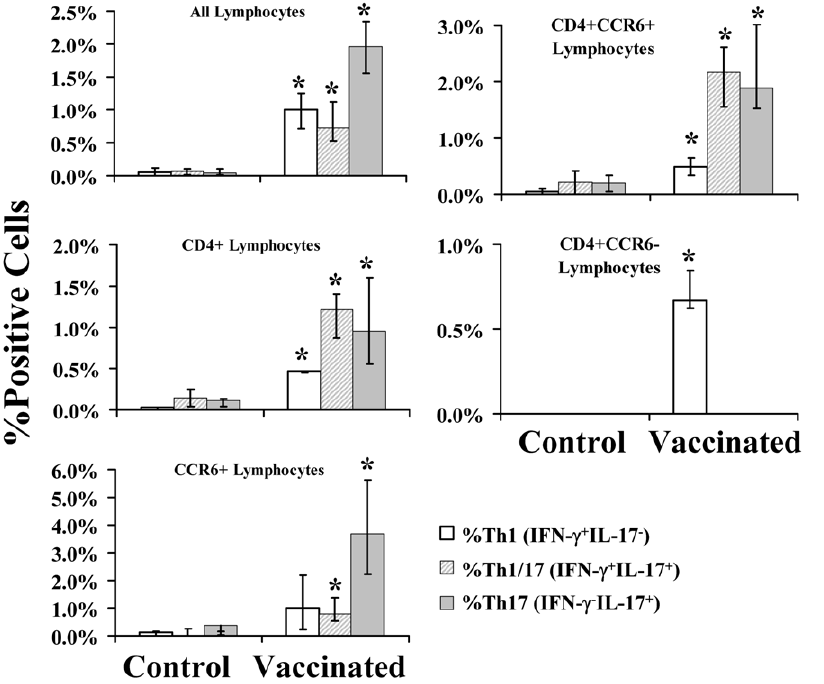
Figure 6. Vaccination primed Th1, Th17, and Th1/17 cells in draining lymph nodes. Balb/c mice, n=4 per group, were vaccinated with rAls3p-N plus Alhydrogel or Alhydrogel alone=Control. Two weeks after the boost cervical and axillary lymph node cells were harvested and incubated for 5 days with rAls3p-N, followed by 6 h with PMA/ionomycin and monensin. Cells were fixed, permeabilized, and stained for CD4, CCR6, IFN- c , or IL-17. Intracellular cytokine analysis was conducted by flow cytometry. ‘‘All Lymphocytes’’ were gated based on size by FSC and density by SSC; CD4 + and CCR6 + lymphocytes were further gated from the ‘‘All Lymphocyte’’ population by fluorescence signal indicating surface expression of these markers. Median and interquartile ranges are shown. *P , 0.05 vs.